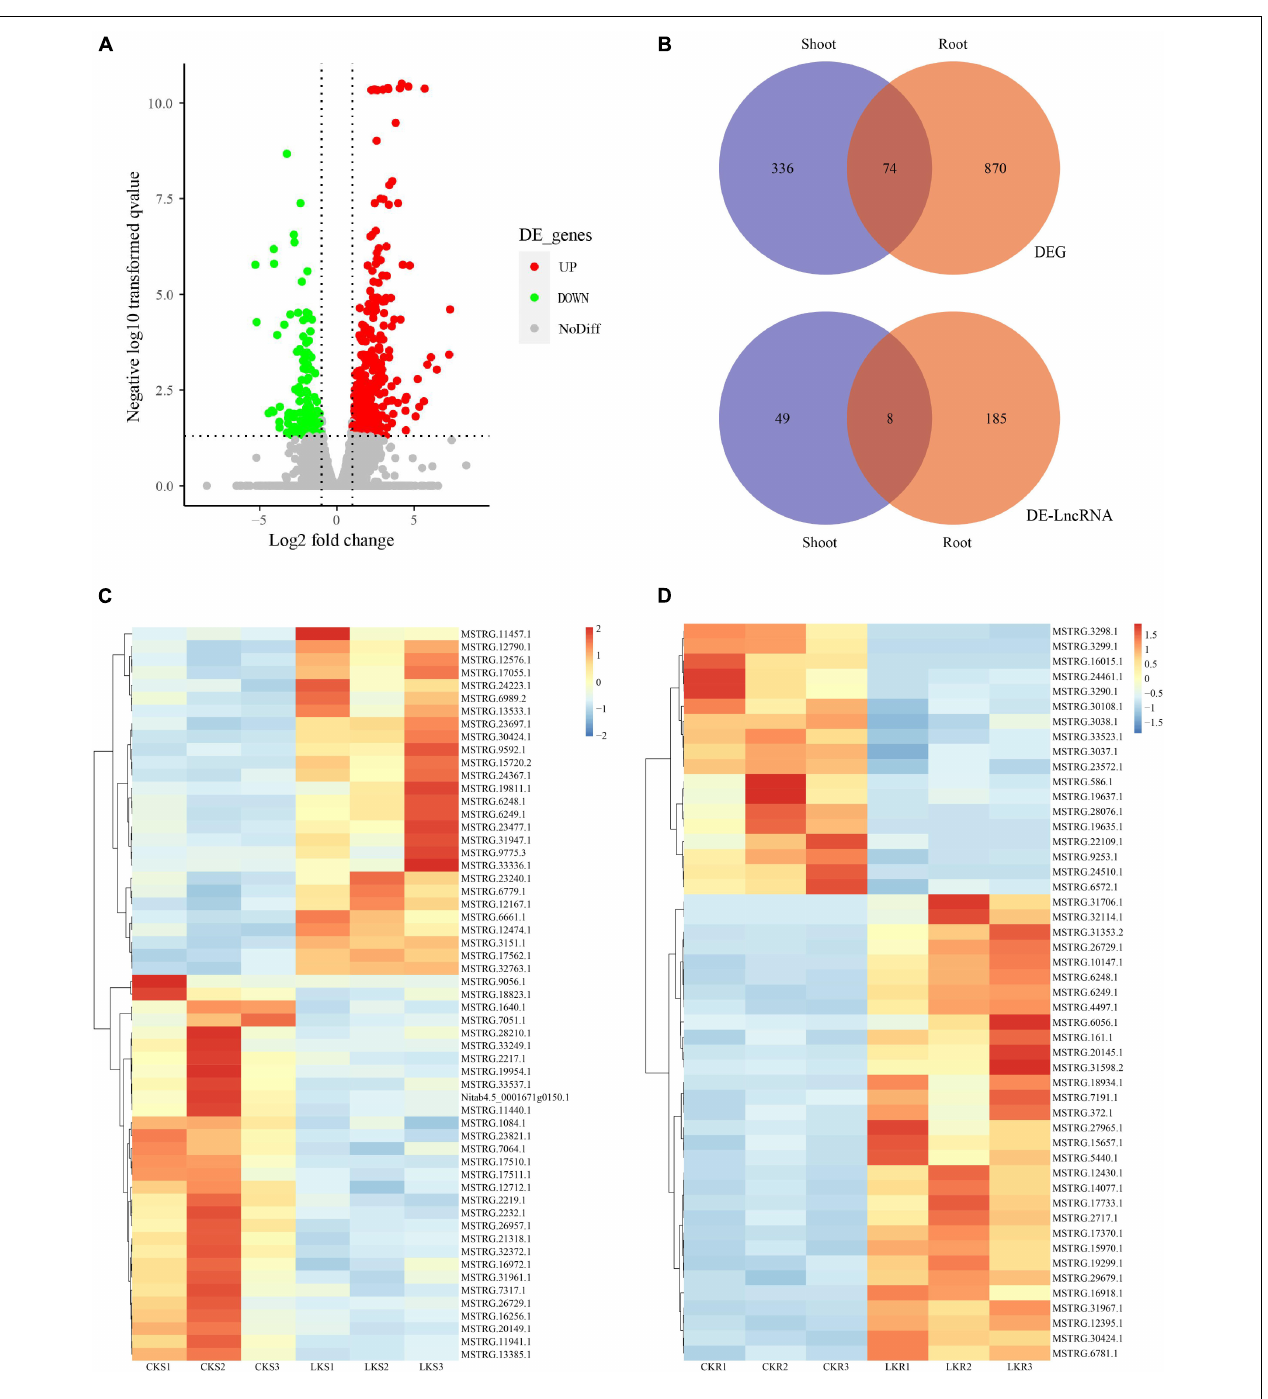
FIGURE 3 | The expression profile of coding RNAs and LncRNAs under low K + . (A) The volcano plot of differentially expressed coding RNAs and LncRNAs. (B) Venn plot of coding RNAs and LncRNAs, and overlap between shoot and root; (C) the heatmap of shoot-specific DE-LncRNAs under low K treatments; (D) the heatmap of root-specific DE-LncRNAs under low K